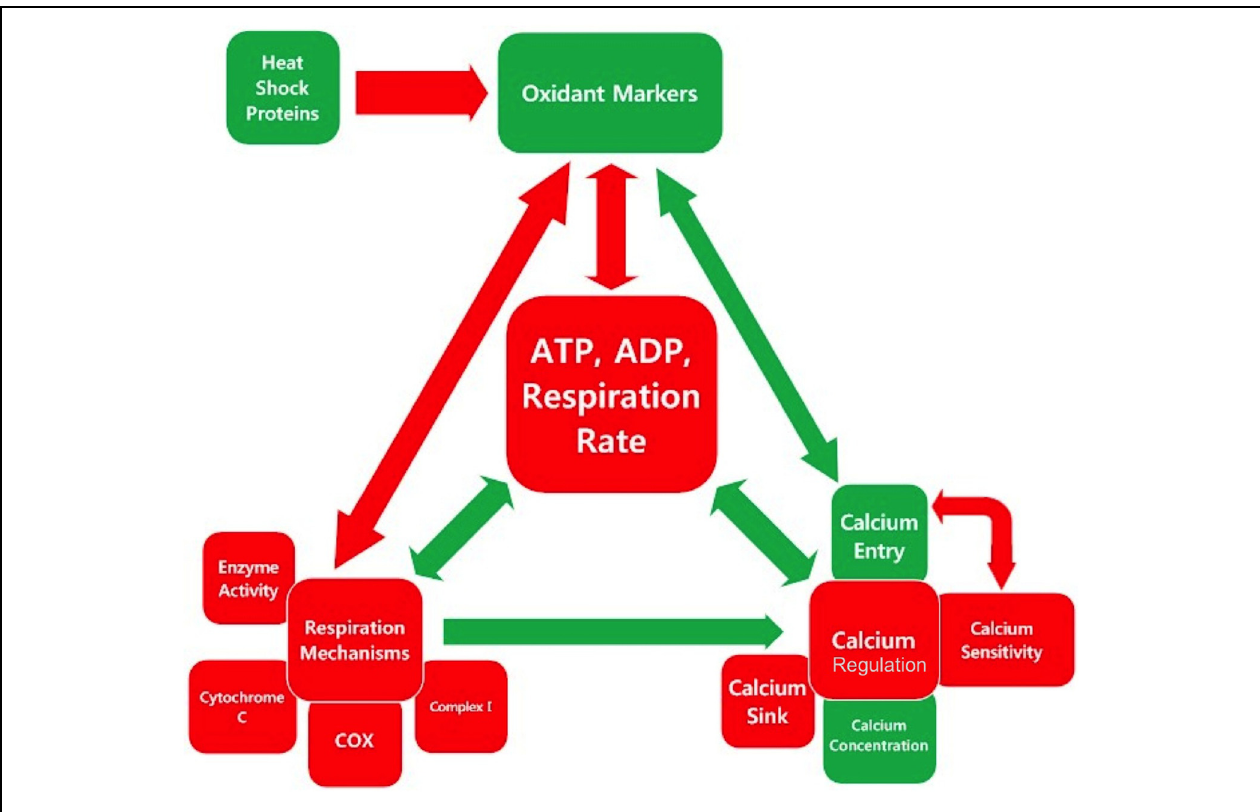
FIGURE 3 | Inter-relationships in the mitochondrial mechanism-oxidative regulation-calcium regulation triad center around cellular respiration. Each square is colored based on whether the assessed category is, on average, higher (green), or lower (red) in